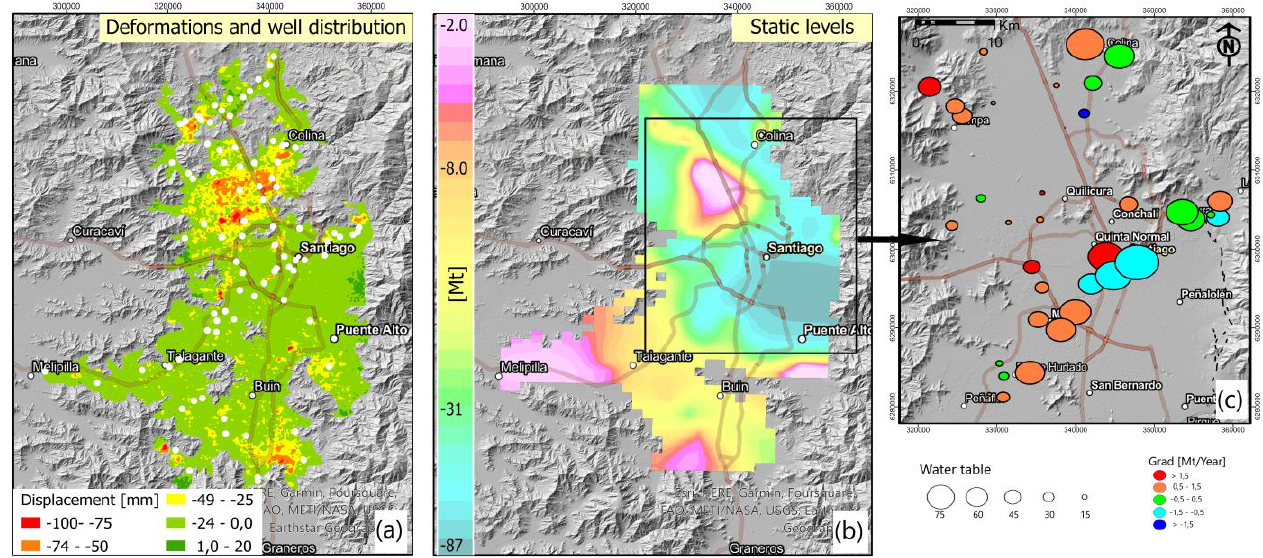
Figure 7. ( a ) Ground deformation map and well distribution in white point color, ( b ) Static level map (modified from DGA 2000), and ( c ) Piezometric variations maps, with ALOS DEM 30 mts used as background.